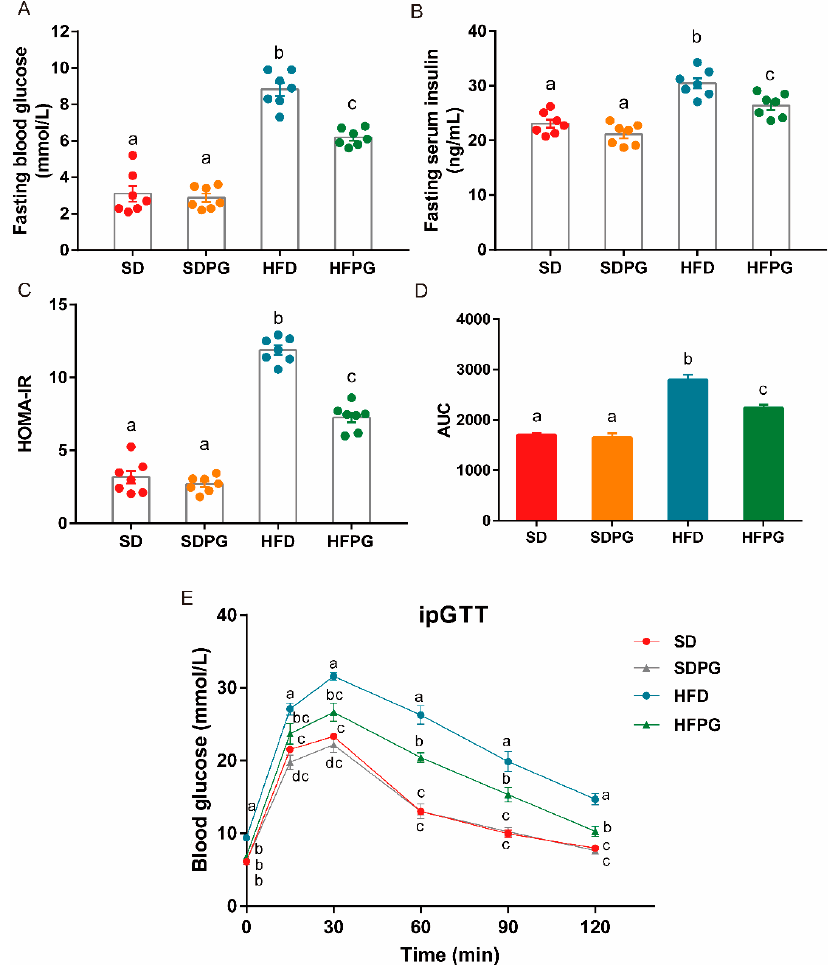
Figure 3. PG improved insulin sensitivity and glucose tolerance in HFD-fed mice. ( A ) Fasting blood glucose level. ( B ) Fasting serum insulin level. ( C ) HOMA-IR index. ( D ) Serum glucose level curves of ipGTT. ( E ) Area under the curve (AUC) of the blood glucose during ipGTT. a, b, c means in the same bar without a common letter differ at p < 0.05.